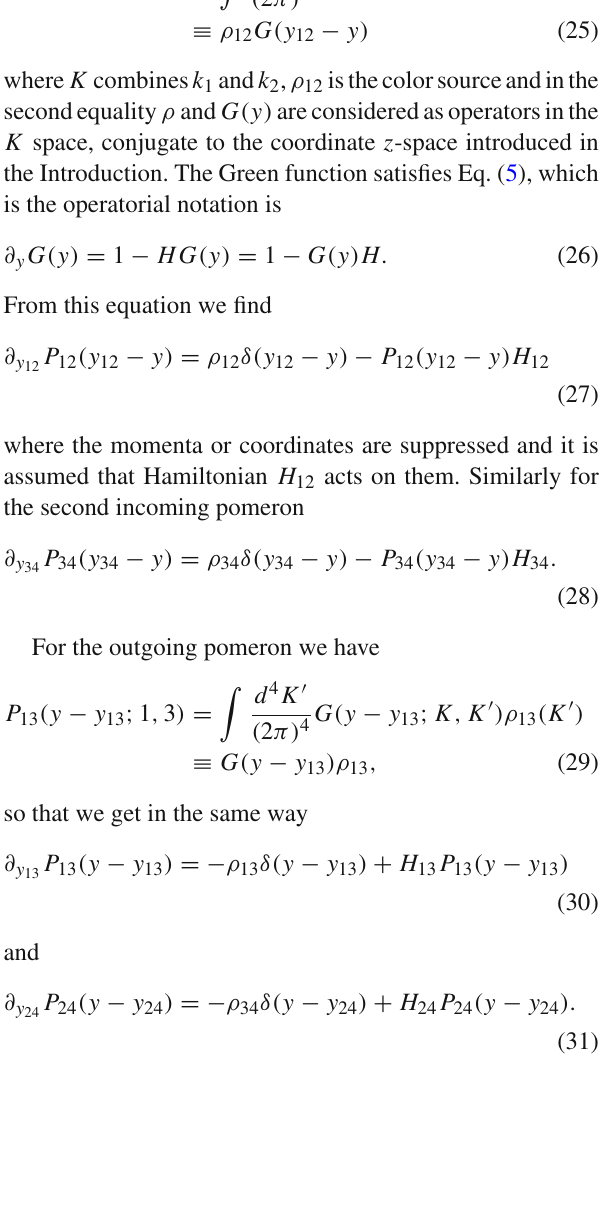
( 1 ) in its turn splits 1